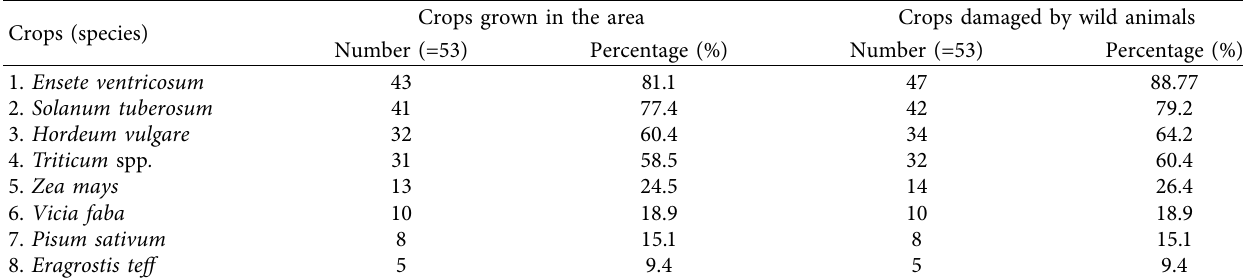
Table 7: Crops grown and damaged in the study area by wild animals.